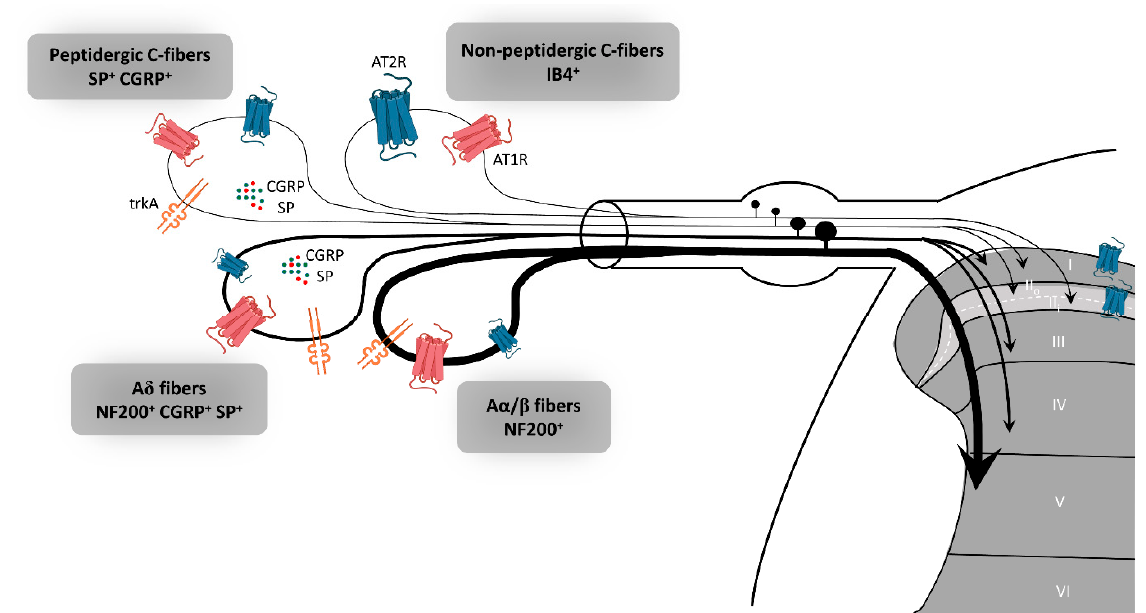
Figure 2. Expression of AT2R in the sensory peripheral nervous system. According to the most recent immunohistochemistry study on the expression of AT2R in DRG and in the spinal cord of rat, AT2R would be expressed by almost all types of sensory neurons, though to different degrees [18]. Non-peptidergic C-nociceptors expressing IB4 are strongly stained for AT2R. Some small and medium DRG neurons co-expressed AT2R and trkA, a marker of nociceptive neurons (peptidergic C and A δ neurons). The few large neurons which express AT2R are stained for NF200 and trkA, markers of A α / β nociceptive neurons. Most ATR2 + neurons are also AT1R + . AT1R: angiotensin II type 1 receptor, AT2R: angiotensin II type 2 receptor, CGRP: calcitonin gene-related peptide, DRG: dorsal root ganglion, IB4: isolectin 4, NF200: neurofilament 200, SP: substance P, trkA: tropomyosin receptor kinase type A.